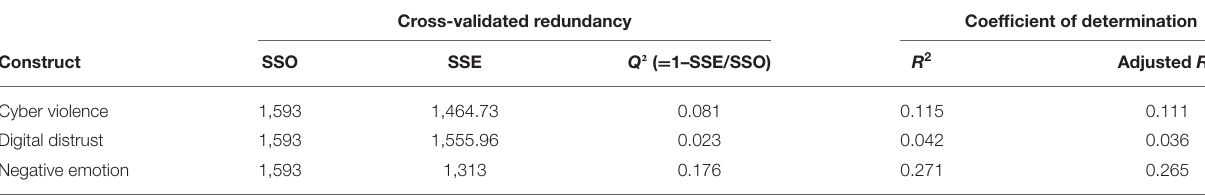
TABLE 6 | Strength of the model. Cross-validated redundancy Coefficient of